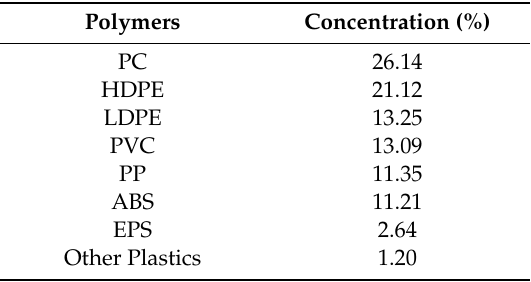
Table 4. Plastic waste